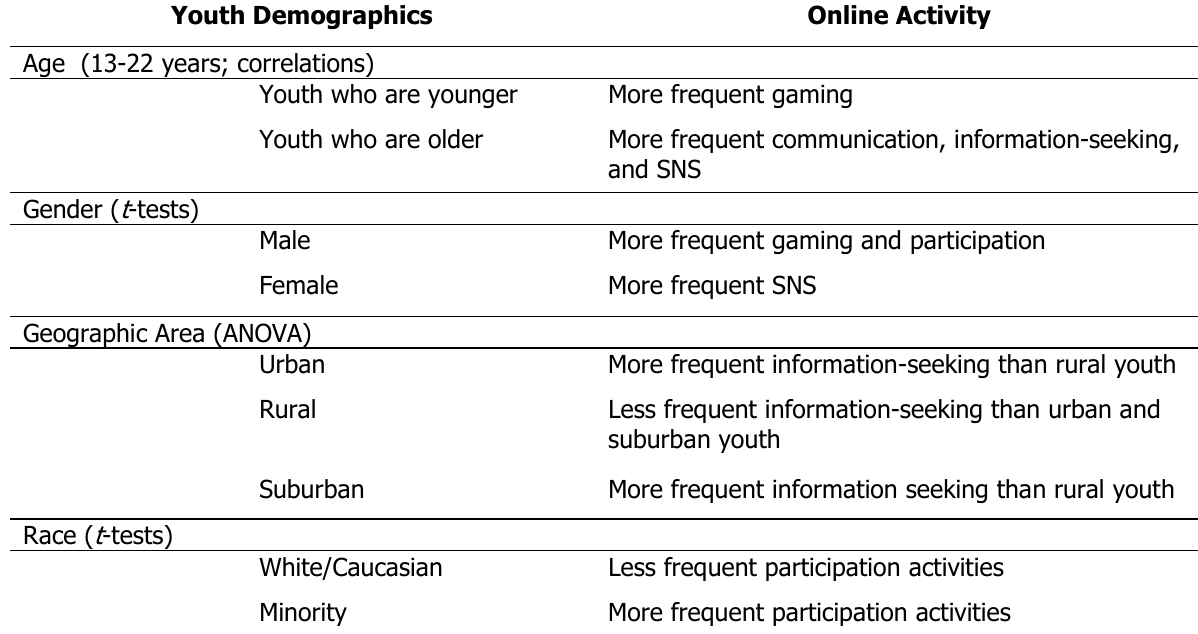
Summary of demographic differences in youth online media use Youth